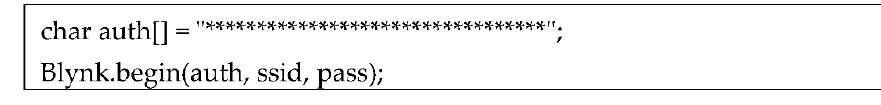
Figure 3. Internet of Things (IoT) Blynk authentiction